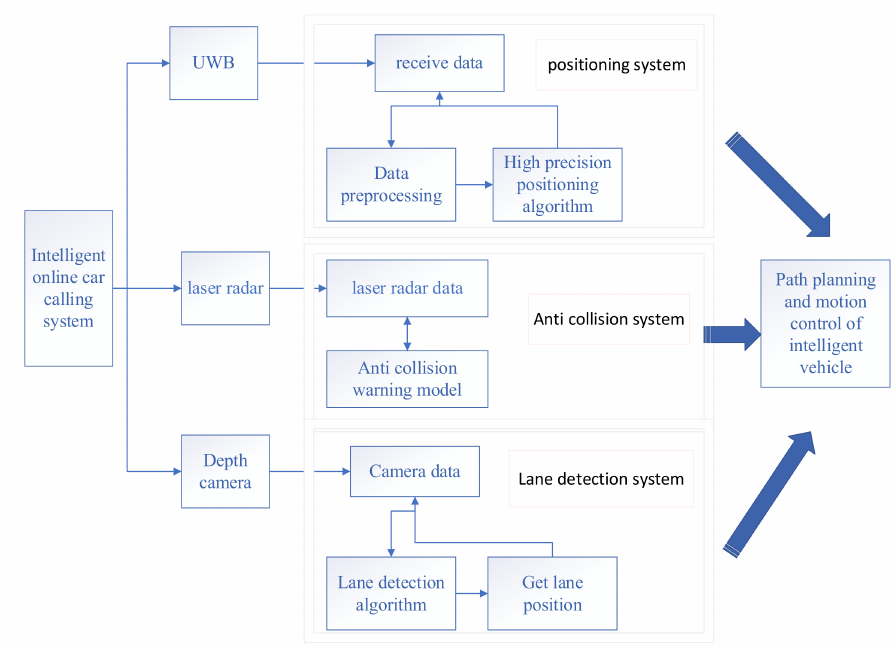
Figure 2. Frame diagram of the car-hailing